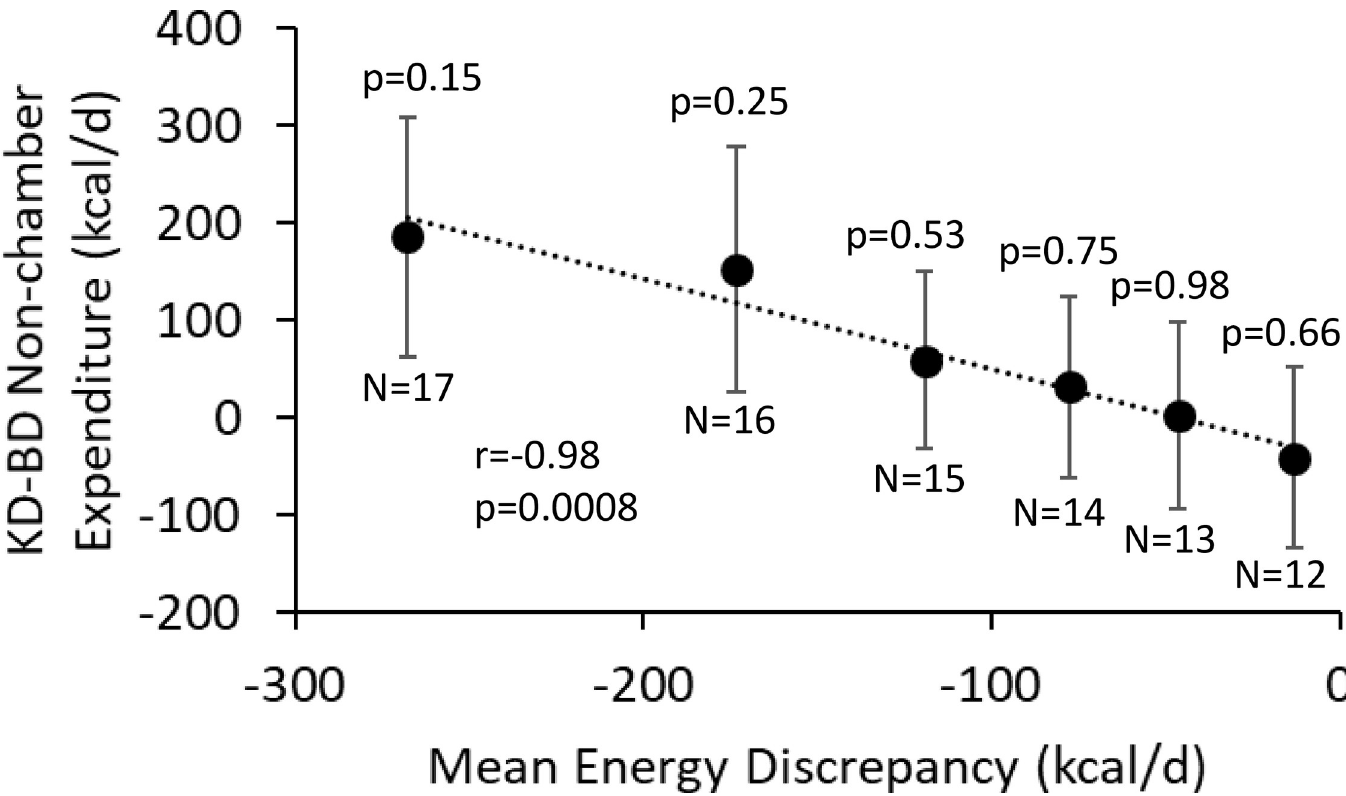
Fig 1. Outlier subjects were responsible for the potentially meaningful differences non-chamber energy expenditure between diet periods. Differences in non- chamber energy expenditure (adjusted for non-chamber RQ) between the isocaloric ketogenic diet (KD) and baseline diet (BD) periods as a function of the mean energy discrepancy as subjects were sequentially removed based on the magnitude of their energy discrepancy. The magnitude of the nominal differences in non-chamber energy expenditure declined as subjects with the largest magnitude energy discrepancies were removed. Mean ± SEM.